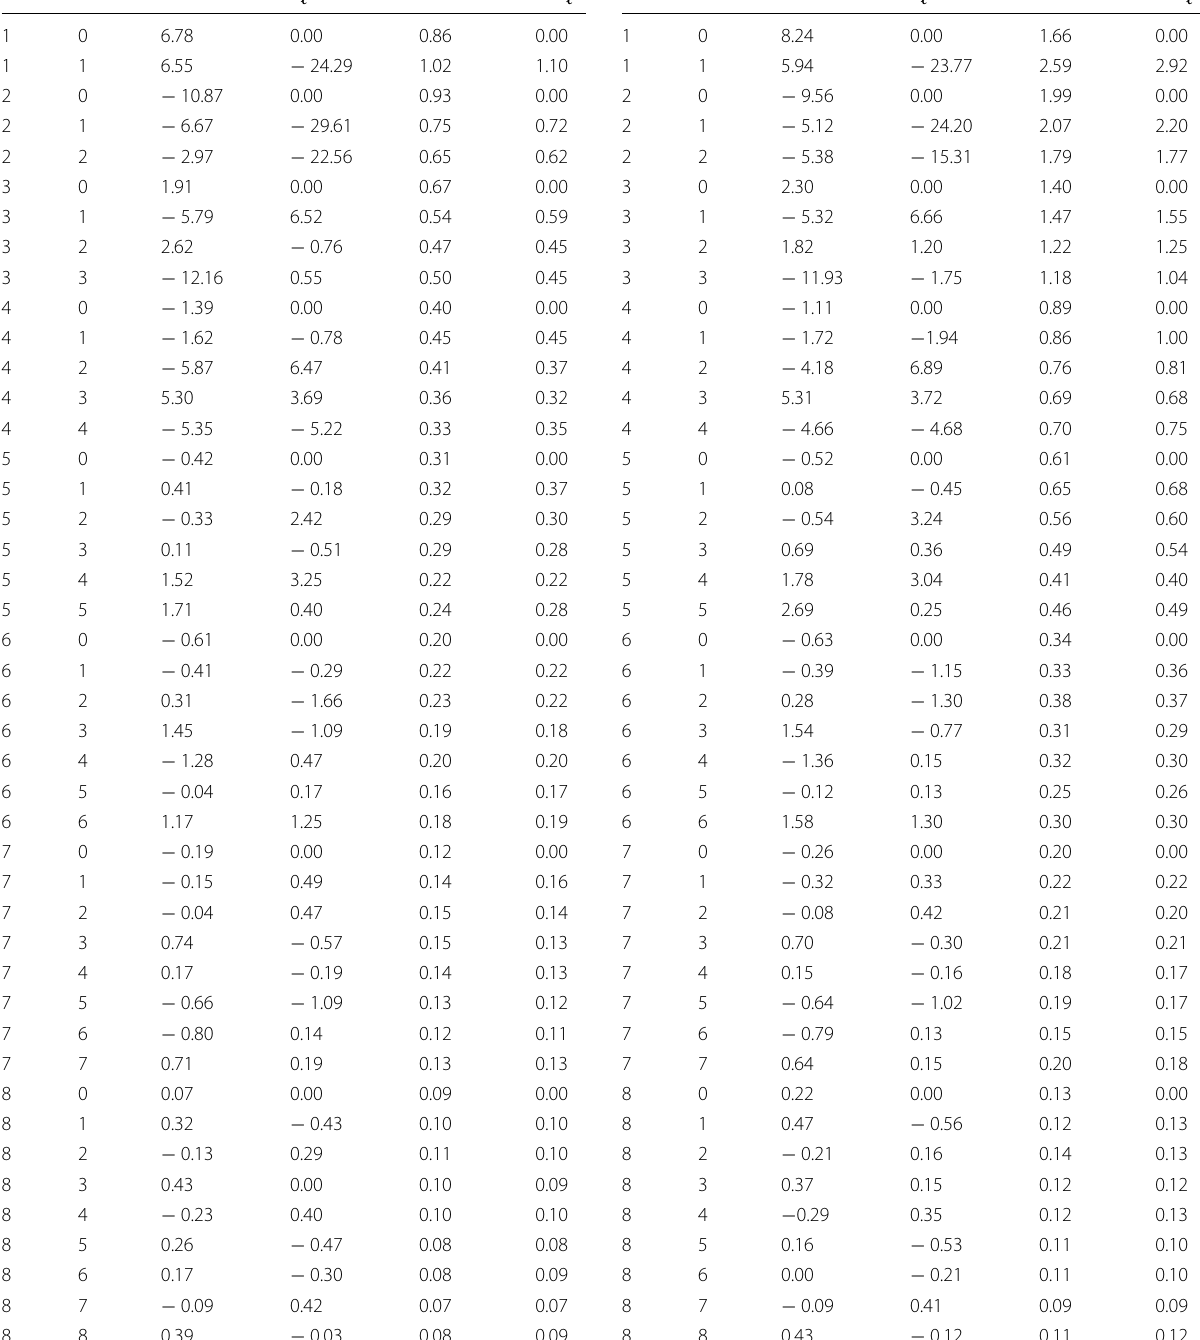
Table 1 SV coefficients and their uncertainties from our candidate model, based on the instantaneous SV in 2020 issued from the assimilation of COV-OBS and